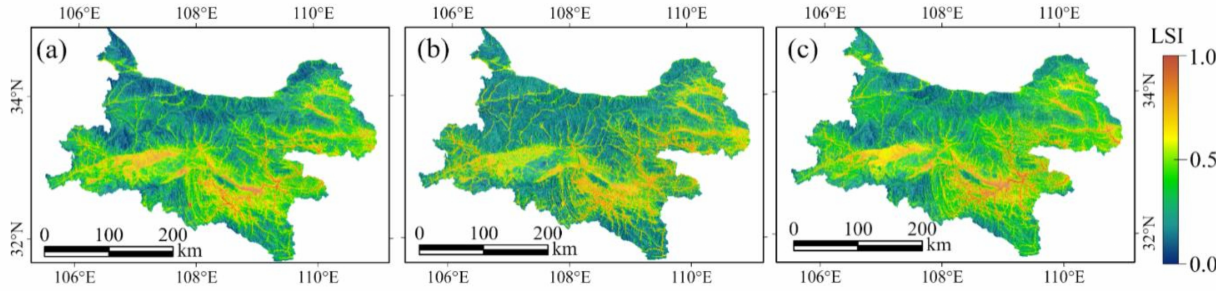
Figure 5. Landslide susceptibility map generated using the ( a ) LR model, ( b ) SVM model, and ( c ) ANN model.